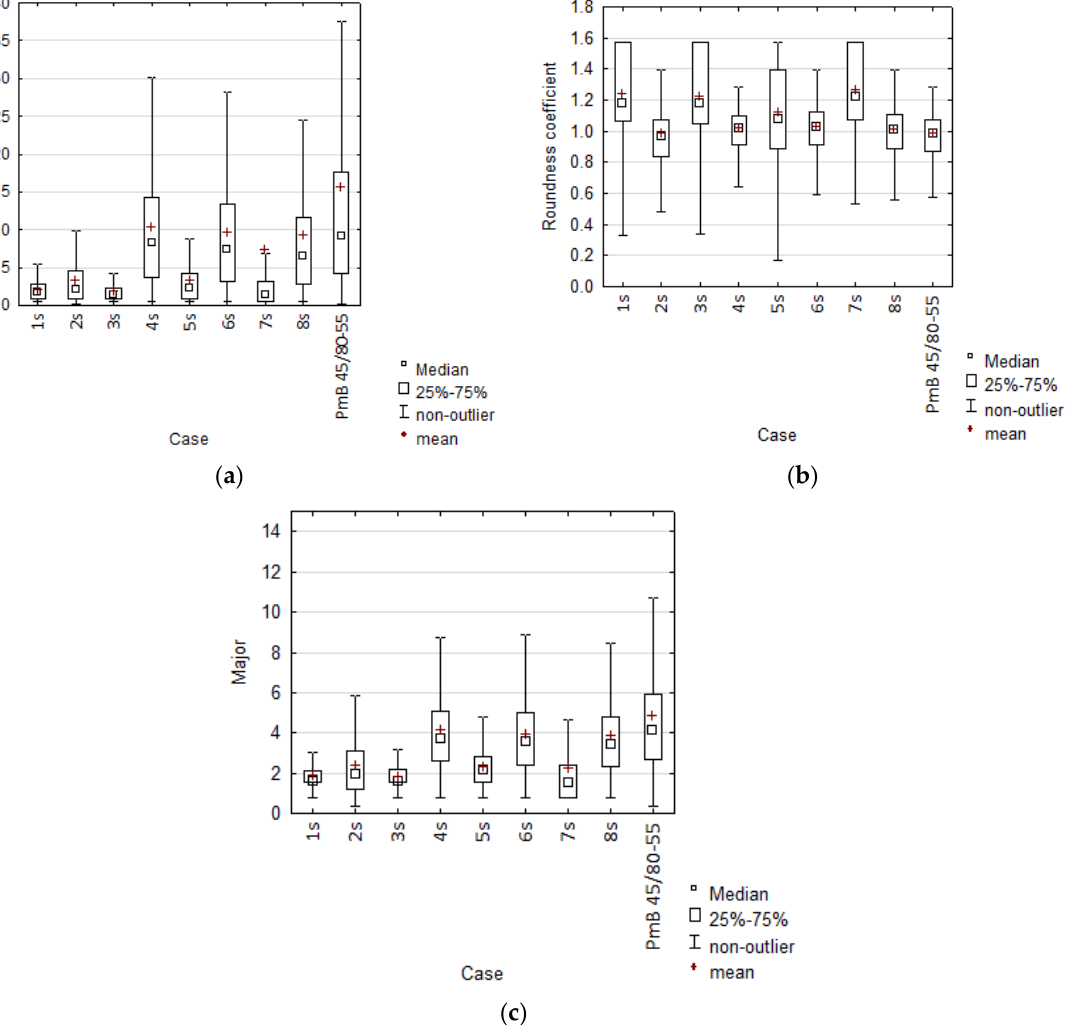
Figure 6. Quantitative analysis of the dispersion of plastomer particles in bitumen: ( a ) particle surface; ( b ) roundness coefficient; ( c ) largest particle size (Major diagonal).